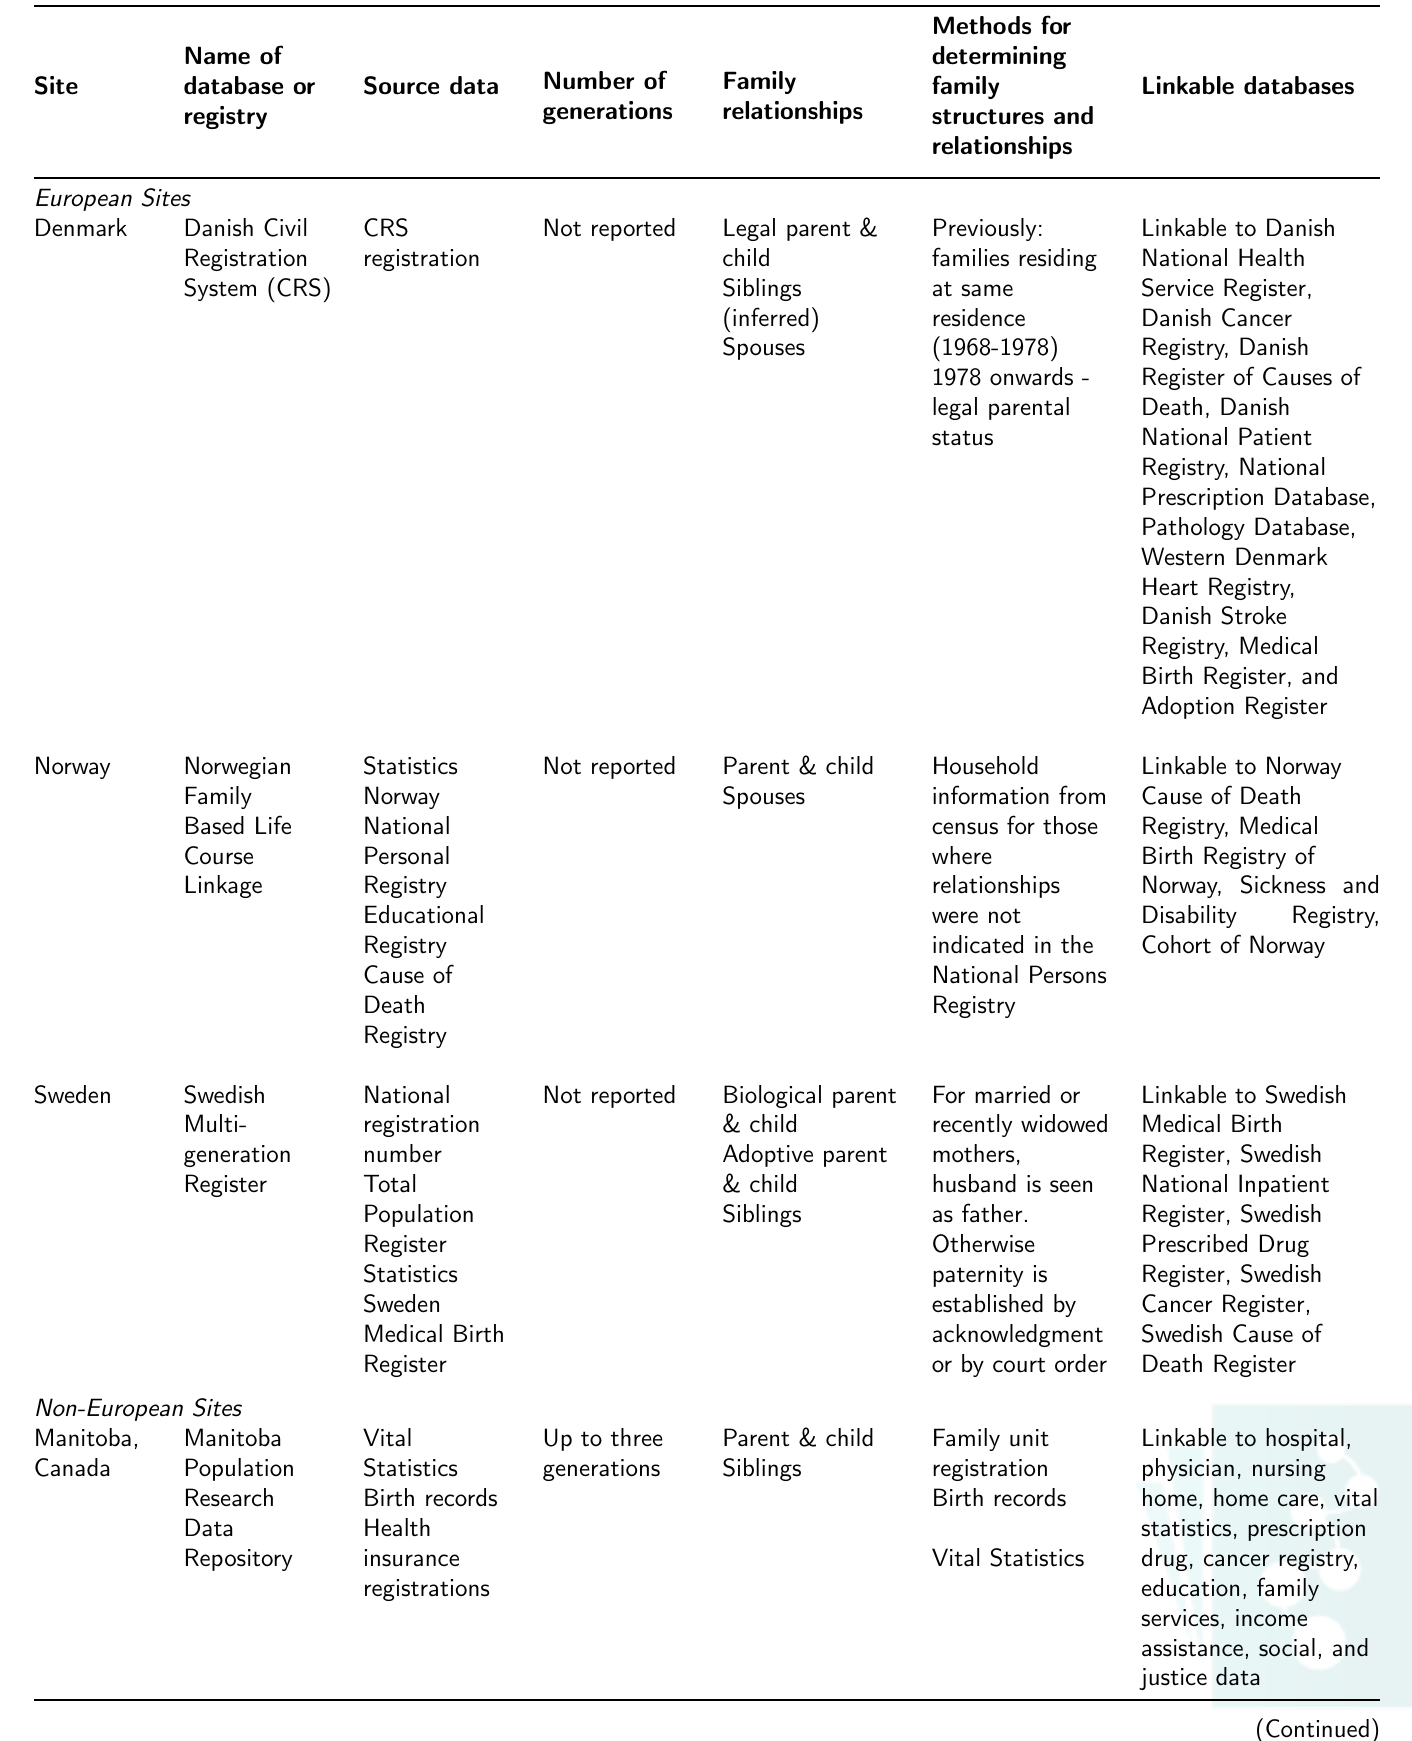
Table 1: Characteristics of electronic health data for population-based multigenerational health research at six